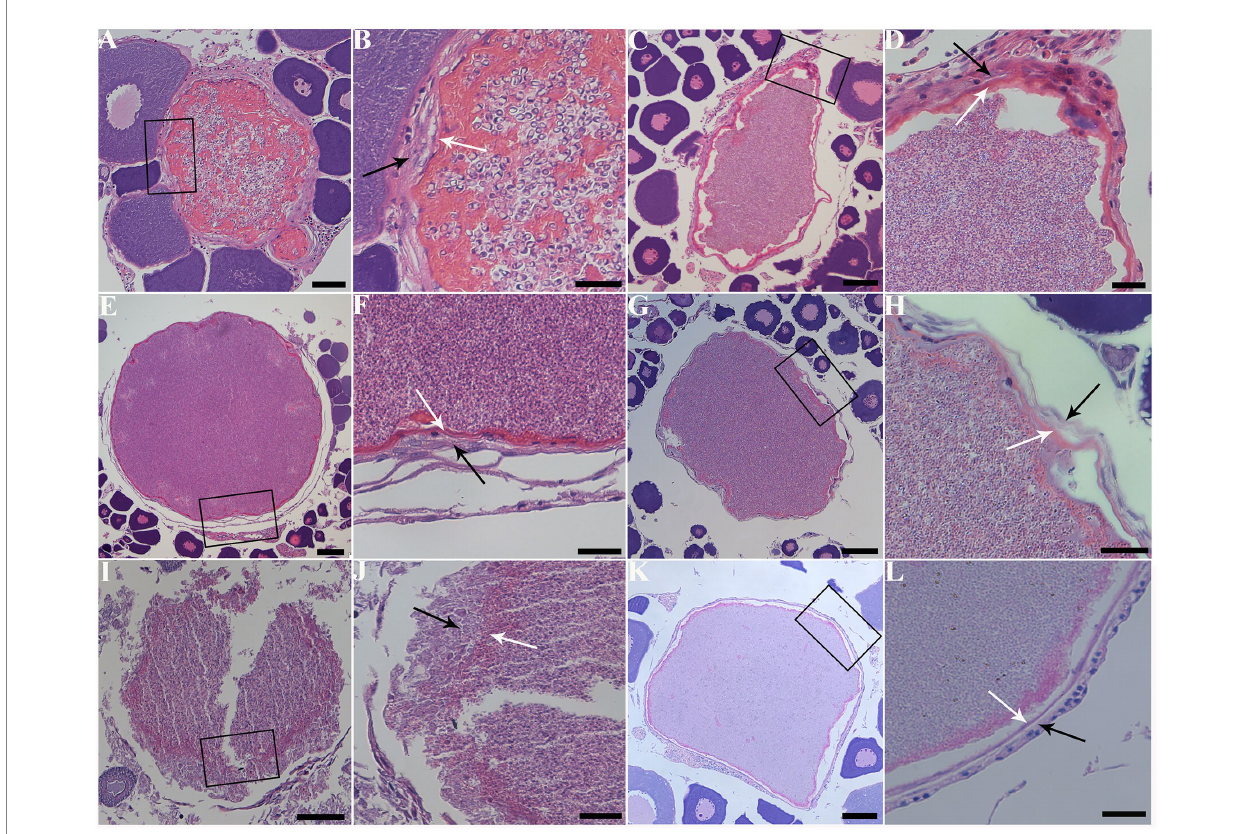
FIGURE 3 Histopathology of the ovary of six fish species with infection of Pseudokabatana alburnus . (A,C,E,G,I,K) A gallery of large parasite-filled cysts isolated from different fish species, demonstrating cysts developing in the connective tissue between the oocytes. (B,D,F,H,J,L) A gallery of magnified images of different pictures, showing the cyst wall (white arrow) surrounded with connective tissue (black arrow). (A) Cultrichthys erythropterus . Scale bar = 50 μ m. (B) The boxed area in (A) . Scale bar = 20 μ m. (C) Pseudolaubuca engraulis . Scale bar = 50 μ m. (D) The boxed area in (C) . Scale bar = 20 μ m. (E) Hemiculter leucisculus . Scale bar = 50 μ m. (F) The boxed area in (E) . Scale bar = 20 μ m. (G) Toxabramis swinhonis . Scale bar = 50 μ m. (H) The boxed area in (G) . Scale bar = 20 μ m. (I) Squaliobarbus curriculus . Scale bar = 50 μ m. (J) The boxed area in (I) . Scale bar = 20 μ m. (K) Elopichthys bambusa . Scale bar = 50 μ m. (L) The boxed area in (K) . Scale bar = 20 μ